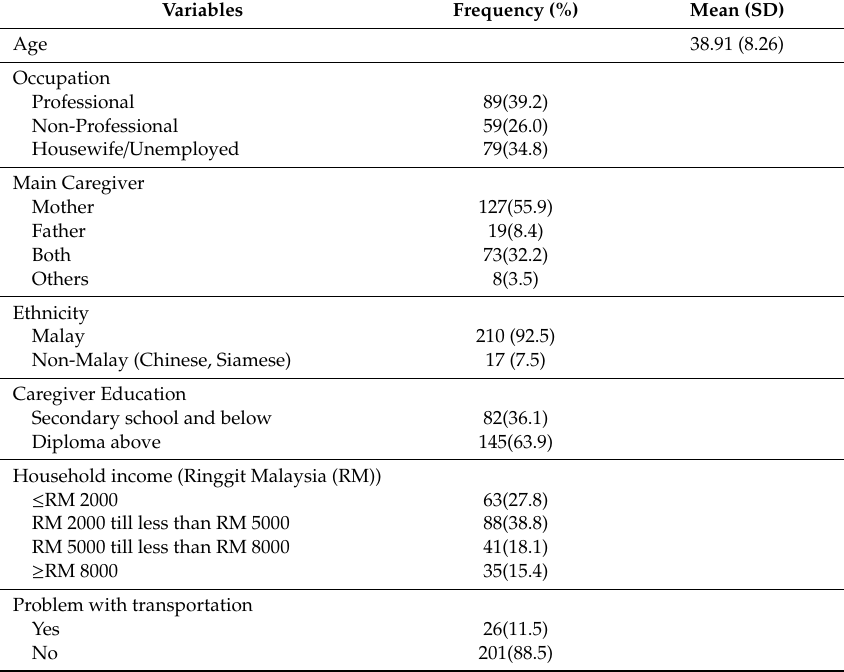
Table 1. Socio-demographic characteristics of the caregivers (n =